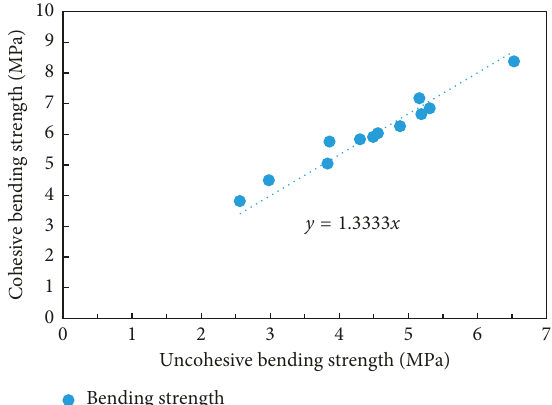
Figure 4: Linear relationship between interlayer cohesive force and no interlayer cohesive